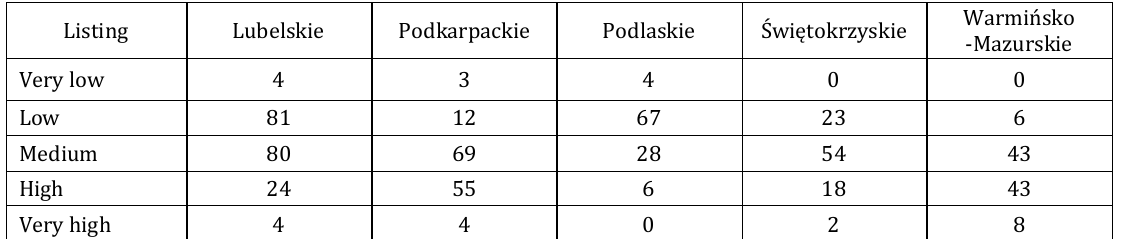
Table 6. Dynamic index for the post-working age population in rural areas of Eastern Poland in the period